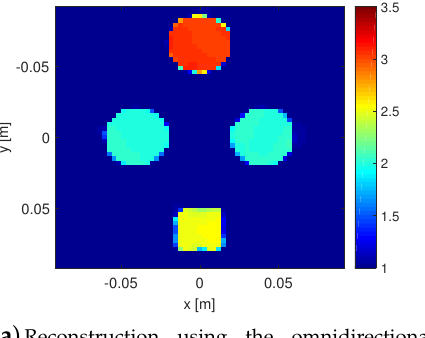
( b ) Reconstruction using the focused incident field for the full circular measurement domain